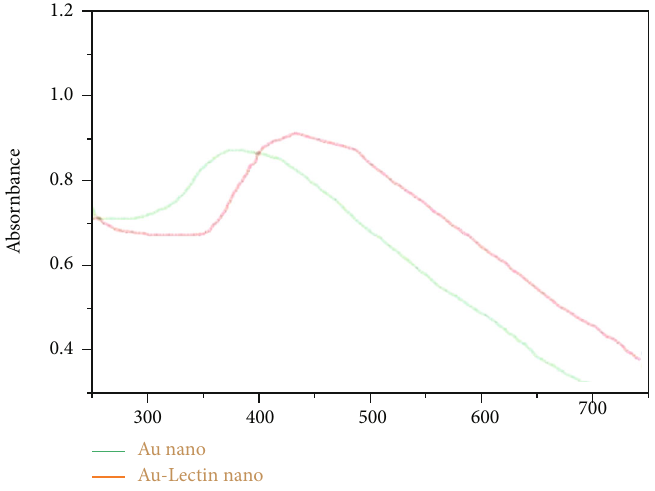
Figure 2: UV spectroscopy of nanoparticle showing the observance of particle.